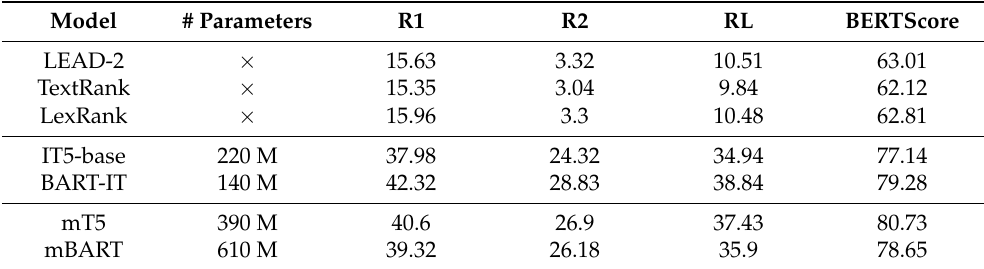
Table 5. Summarization evaluation results on the WITS dataset. The # parameters column is empty for unsupervised baseline models since they do not include any trainable